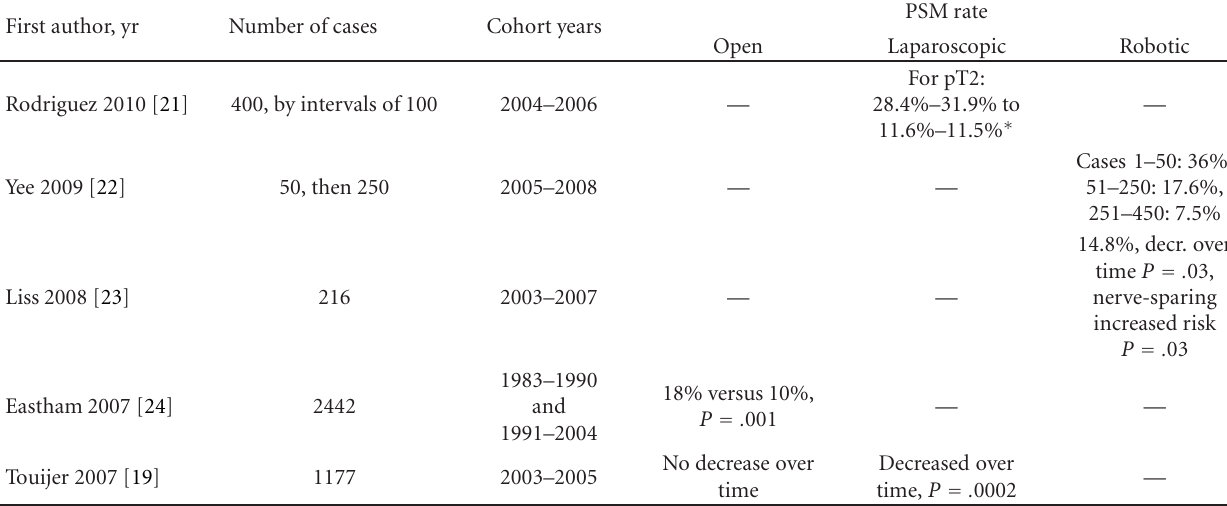
Table 2: Comparison of PSM rates by duration of surgical experience.